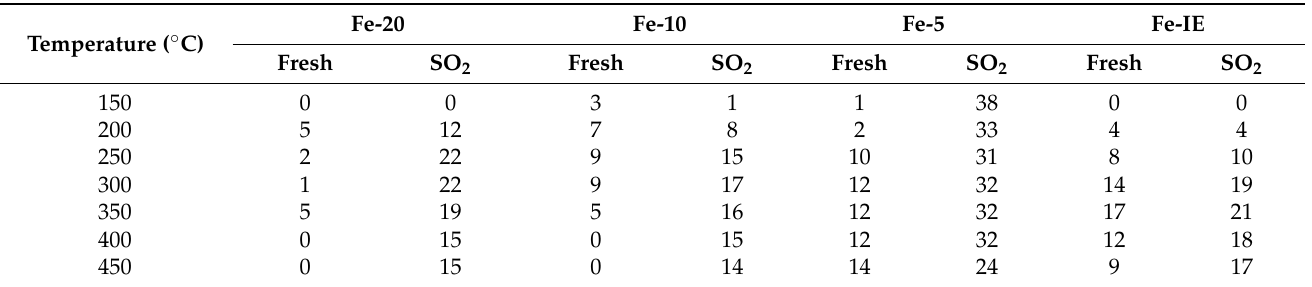
Table 1. N 2 O concentration (in ppm) at the outlet of the reactor, detected for the fresh and SO 2 - poisoned catalysts.